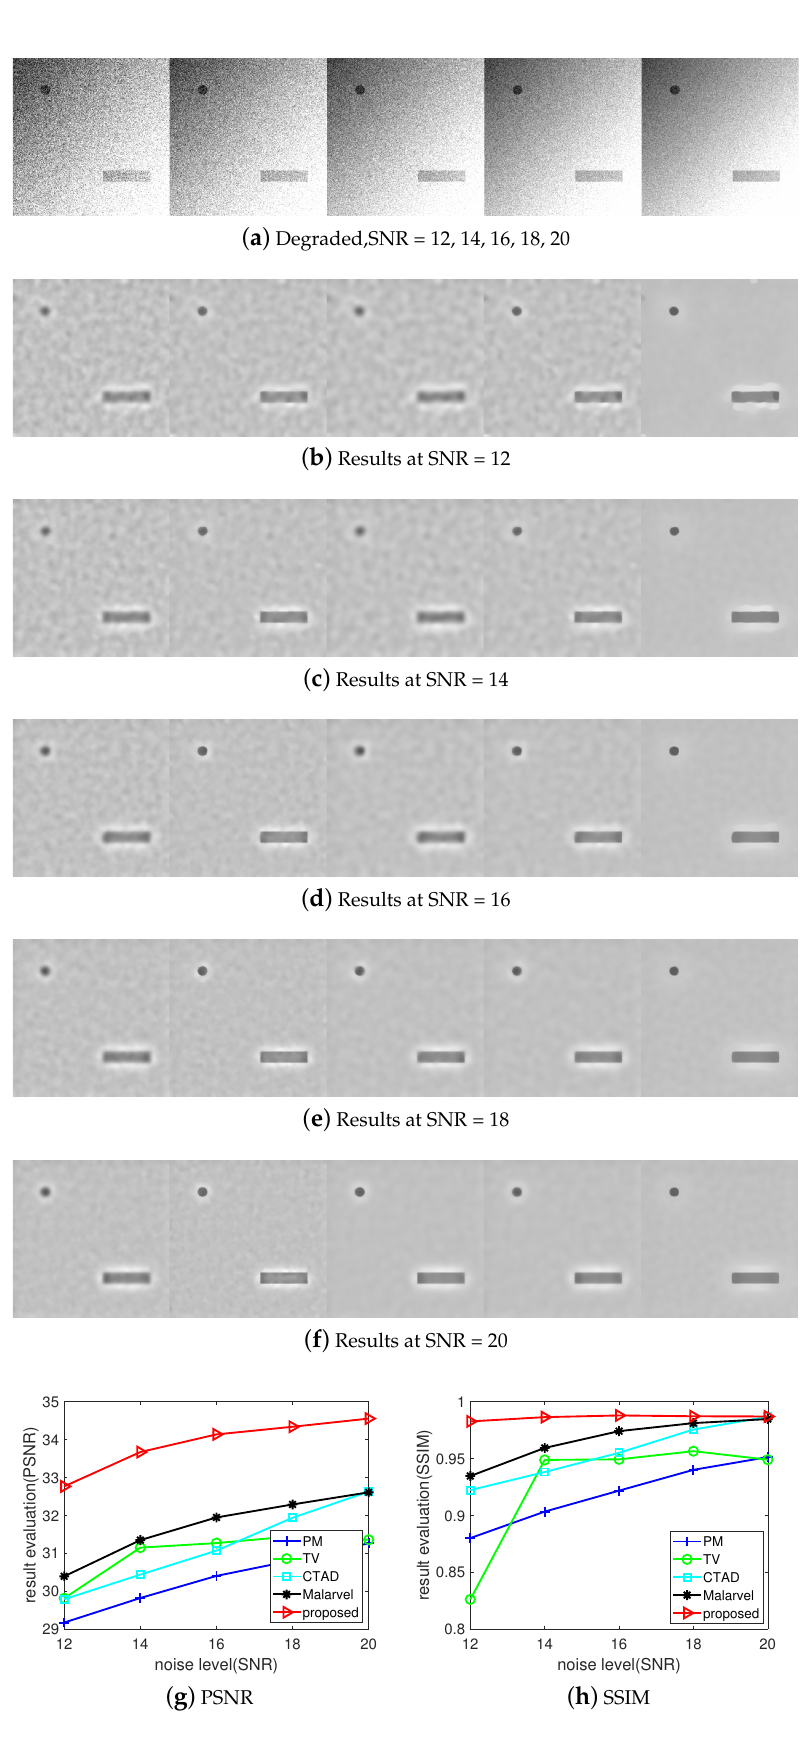
Figure 3. Results of test on artificial image